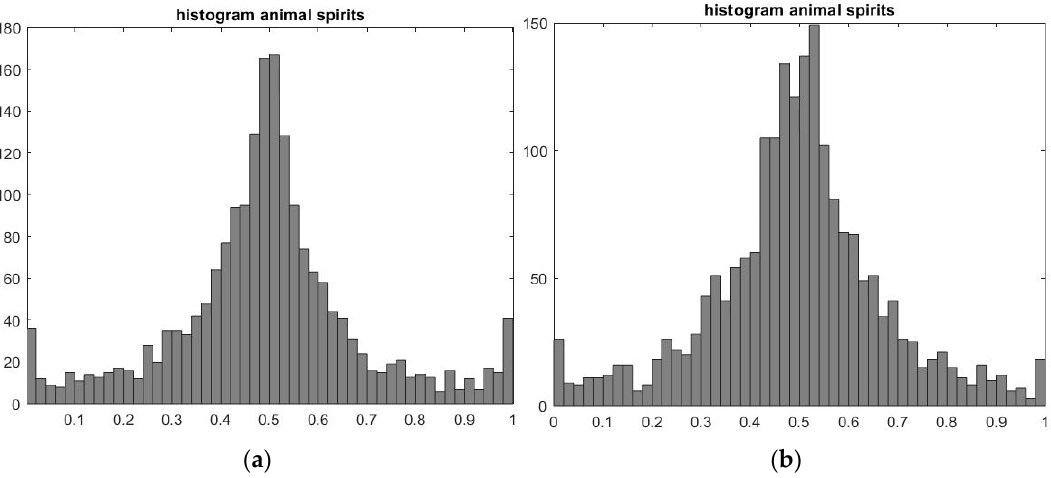
Figure 6. ( a ) a histogram of the frequency distribution of the degree of vitality for a model with an imperfect labor market when forecasting wage inflation only using the fundamentalist rule (24) and with a zero coefficient φ w in the Taylor rule for the interest rate; ( b ) Histogram for the base model with fixed prices and flexible wages for price inflation and output gap forecasting using two rules and non-zero coefficients φ π , φ y in the Taylor rule. The coefficients for both models correspond to those of Table 2.